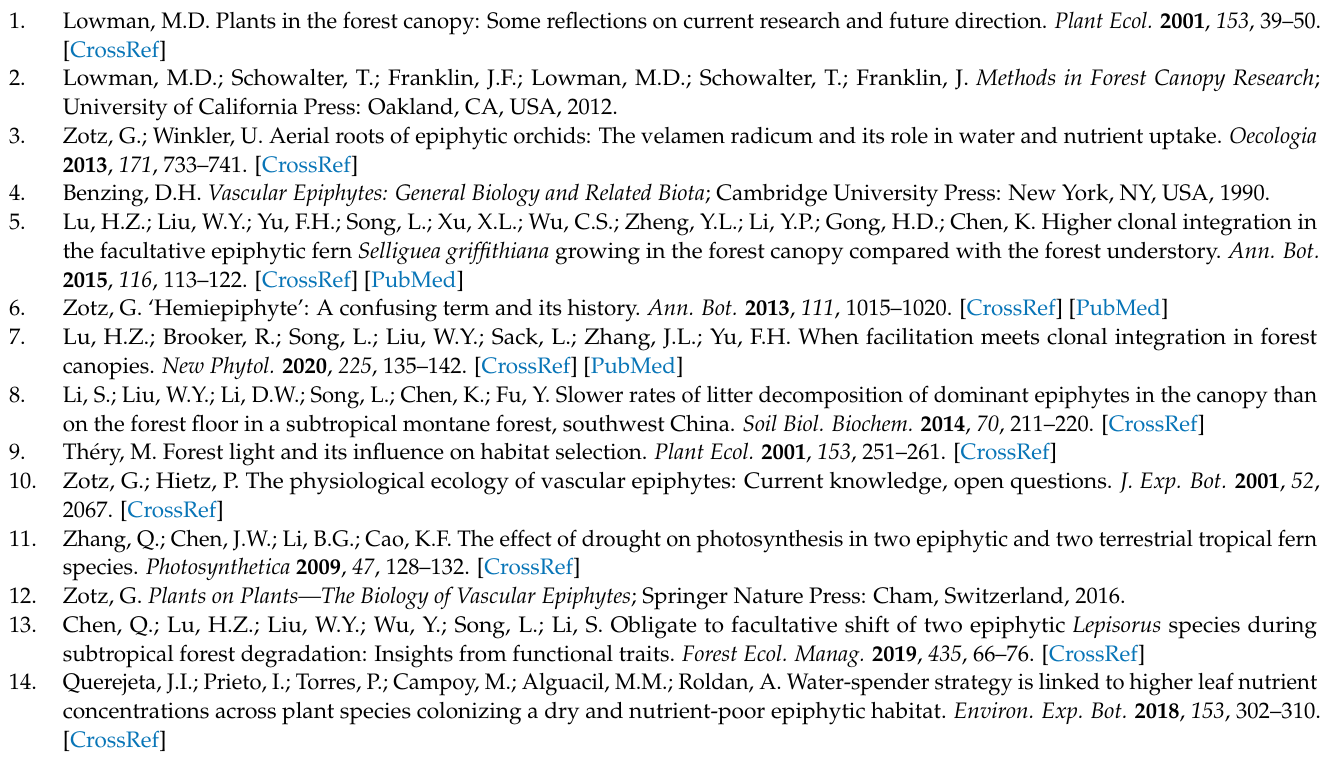
gracilis between epiphytic and terrestrial habitats. Table S2: The difference of stoichiometric traits of C, N, and P concentrations and their element ratios in different organs of E. monandrum between epiphytic and terrestrial habitats. Table S3: The difference of stoichiometric traits of C, N, and P concentrations and their element ratios in different organs of B. longifolia between epiphytic and terrestrial habitats. Table S4: The stoichiometric homeostasis values for different elements, organs, and species in the field experiment. Table S5: Comparison of stoichiometric homeostasis values (mean ± SE) for different organs, and species in the field study and the effects of organ, species and their interactions on stoichiometry